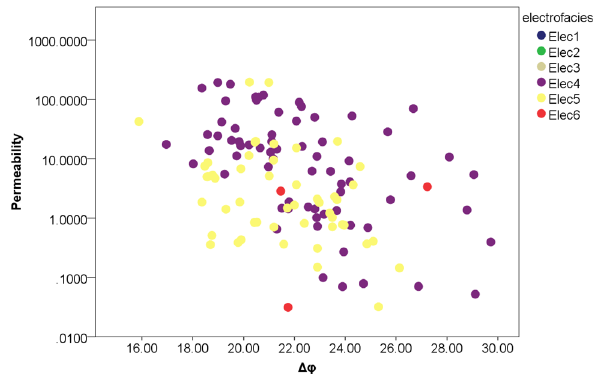
Fig. 11 𝛥𝜑 –K crossplot in